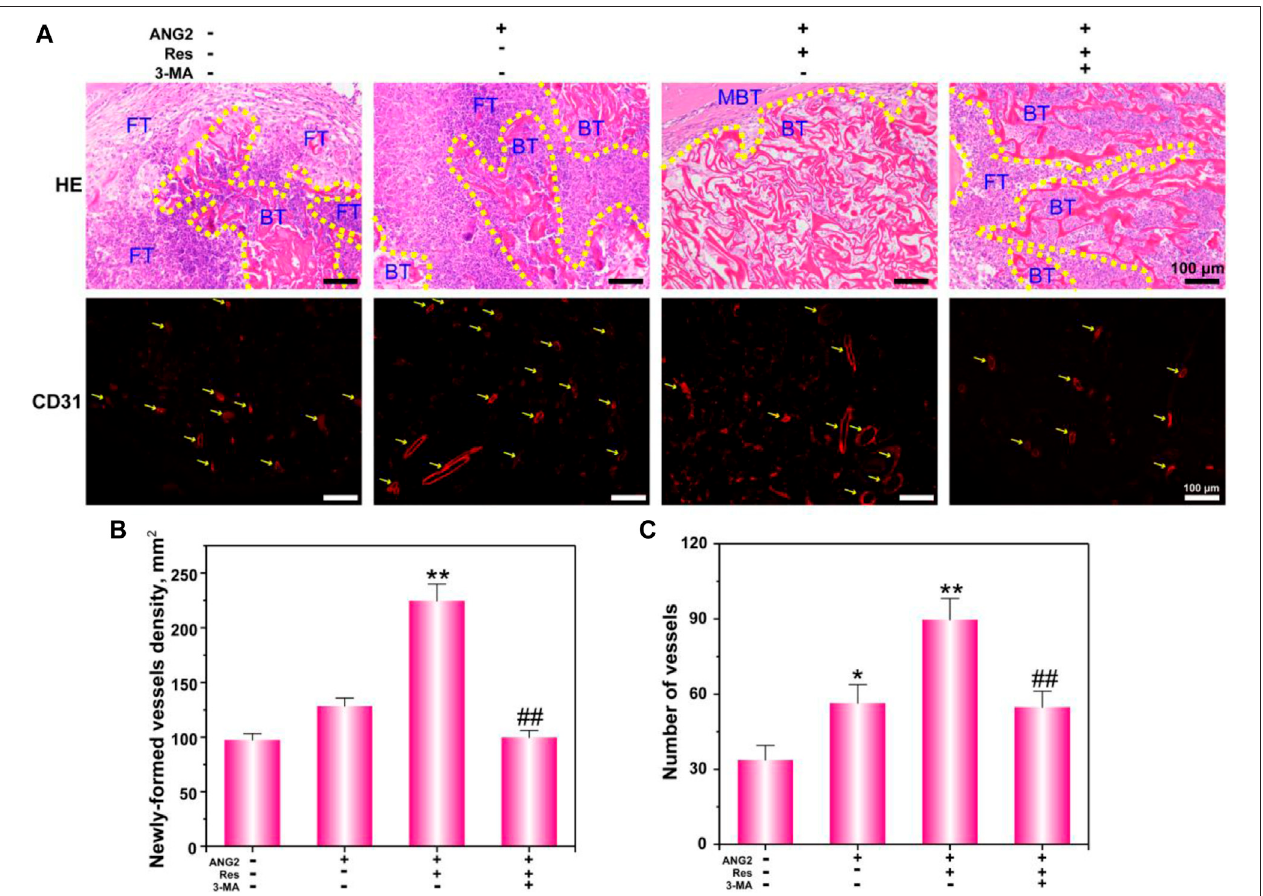
FIGURE 7 | Histological analysis (A) of bone defects via H&E staining and CD31 immuno fl uorescence staining; FT indicates “ fi ber texture ” , BT indicates “ bone tissue ” , and MBT indicates “ mature bone tissue ” . The newly formed vessel density and number were determined. The values are represented as the mean ± SD ( n (cid:1) 6). * p < 0.05, ** p < 0.01 vs ANG2 group; # p < 0.05, ## p < 0.01 vs ANG2/Res